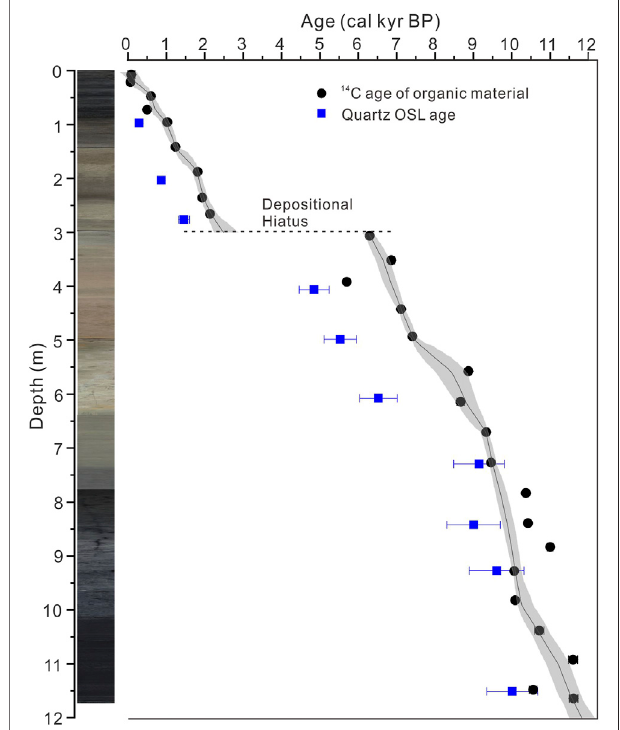
FIGURE 3 | Lithology, quartz OSL ages, 14 C ages of bulk organic materials, and age-depth model for sediment core CG18B from Chagan Nur (Redraw accorded by Li et al., 2020 with the IntCal20